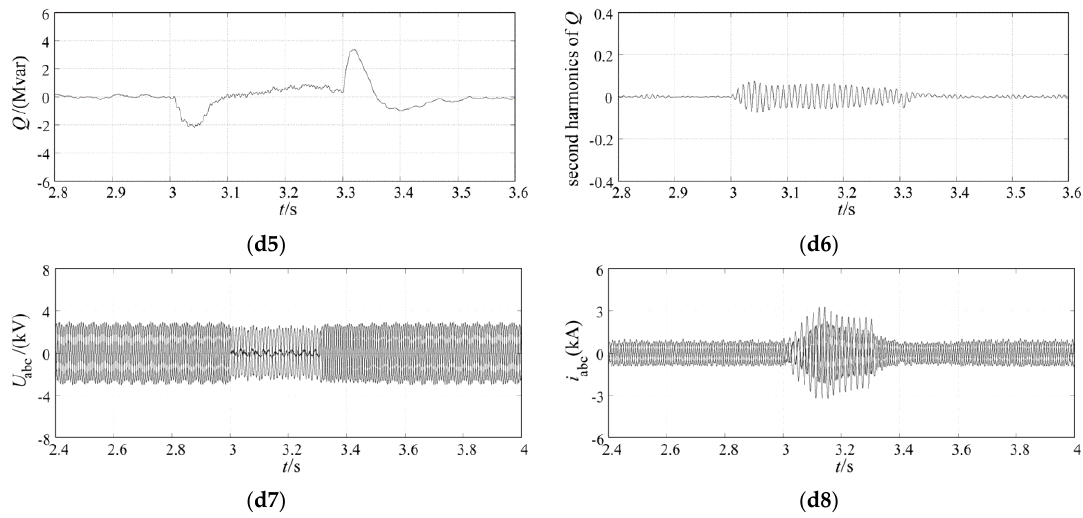
Figure 10. Simulation results of phase-to-phase grid fault condition under different controllers. ( a1 ) U dc (conventional control); ( a2 ) Second harmonics of U dc (conventional control); ( a3 ) P (conventional control); ( a4 ) Second harmonics of P (conventional control); ( a5 ) Q (conventional control); ( a6 ) Second harmonics of Q (conventional control); ( a7 ) Voltages at the low-voltage side of transformer (conventional control); ( a8 ) Currents at the low-voltage side of transformer (conventional control); ( b1 ) U dc (DDSRF control I); ( b2 ) Second harmonics of U dc (DDSRF control I); (b3 ) P (DDSRF control I);